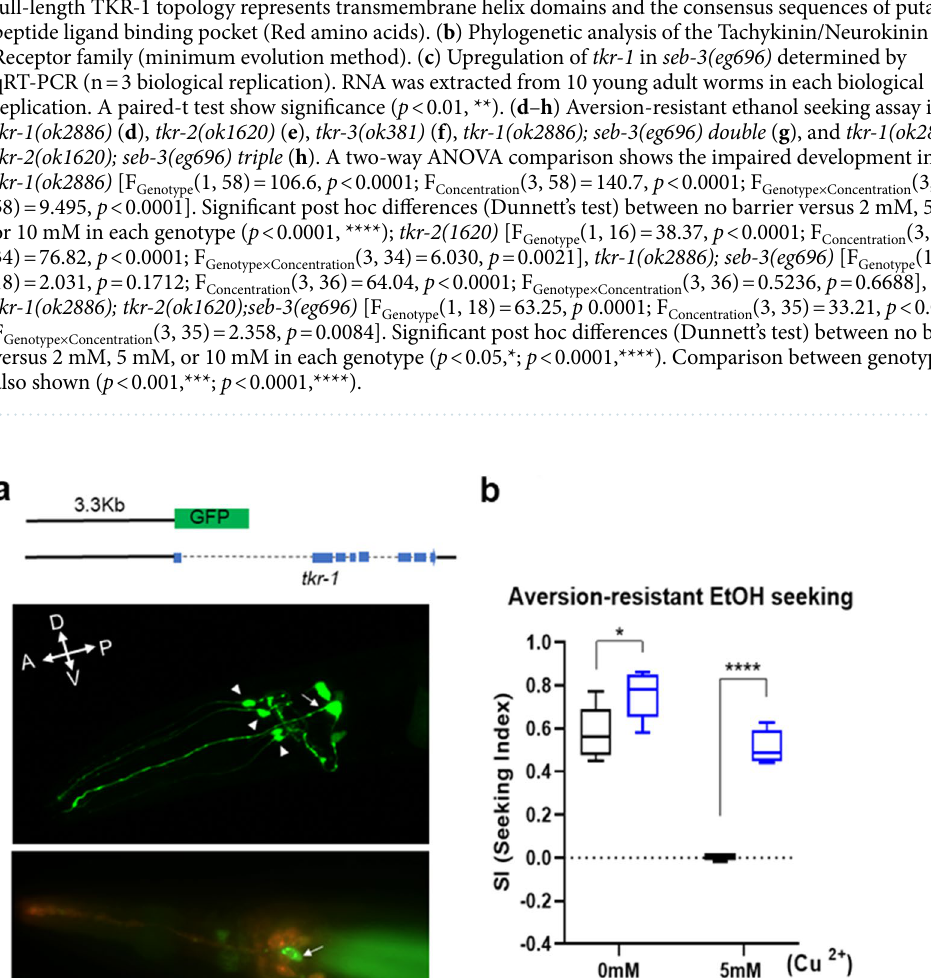
in the pathophysiology of compulsive behavior such as anxiety and AUD 113–115 . Stress pathways have been studied as key fundamentals of neural systems that drive alcohol and drug dependence. The brain stress system is activated and sensitized during repeated withdrawal and lead to a negative emotional state that promotes dependence 116 . Indeed, the seb-3(eg696) gf animals, originally isolated as a genetic variant showing